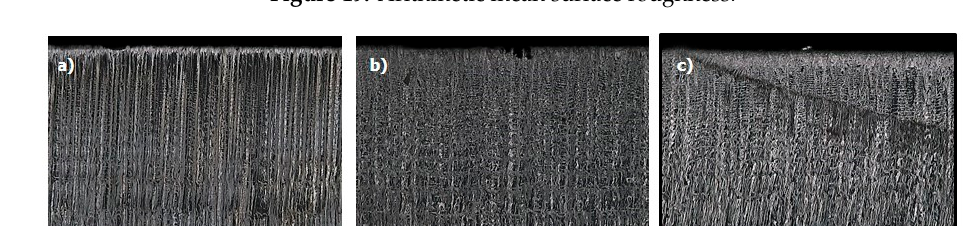
Figure 19. Arithmetic mean surface roughness.